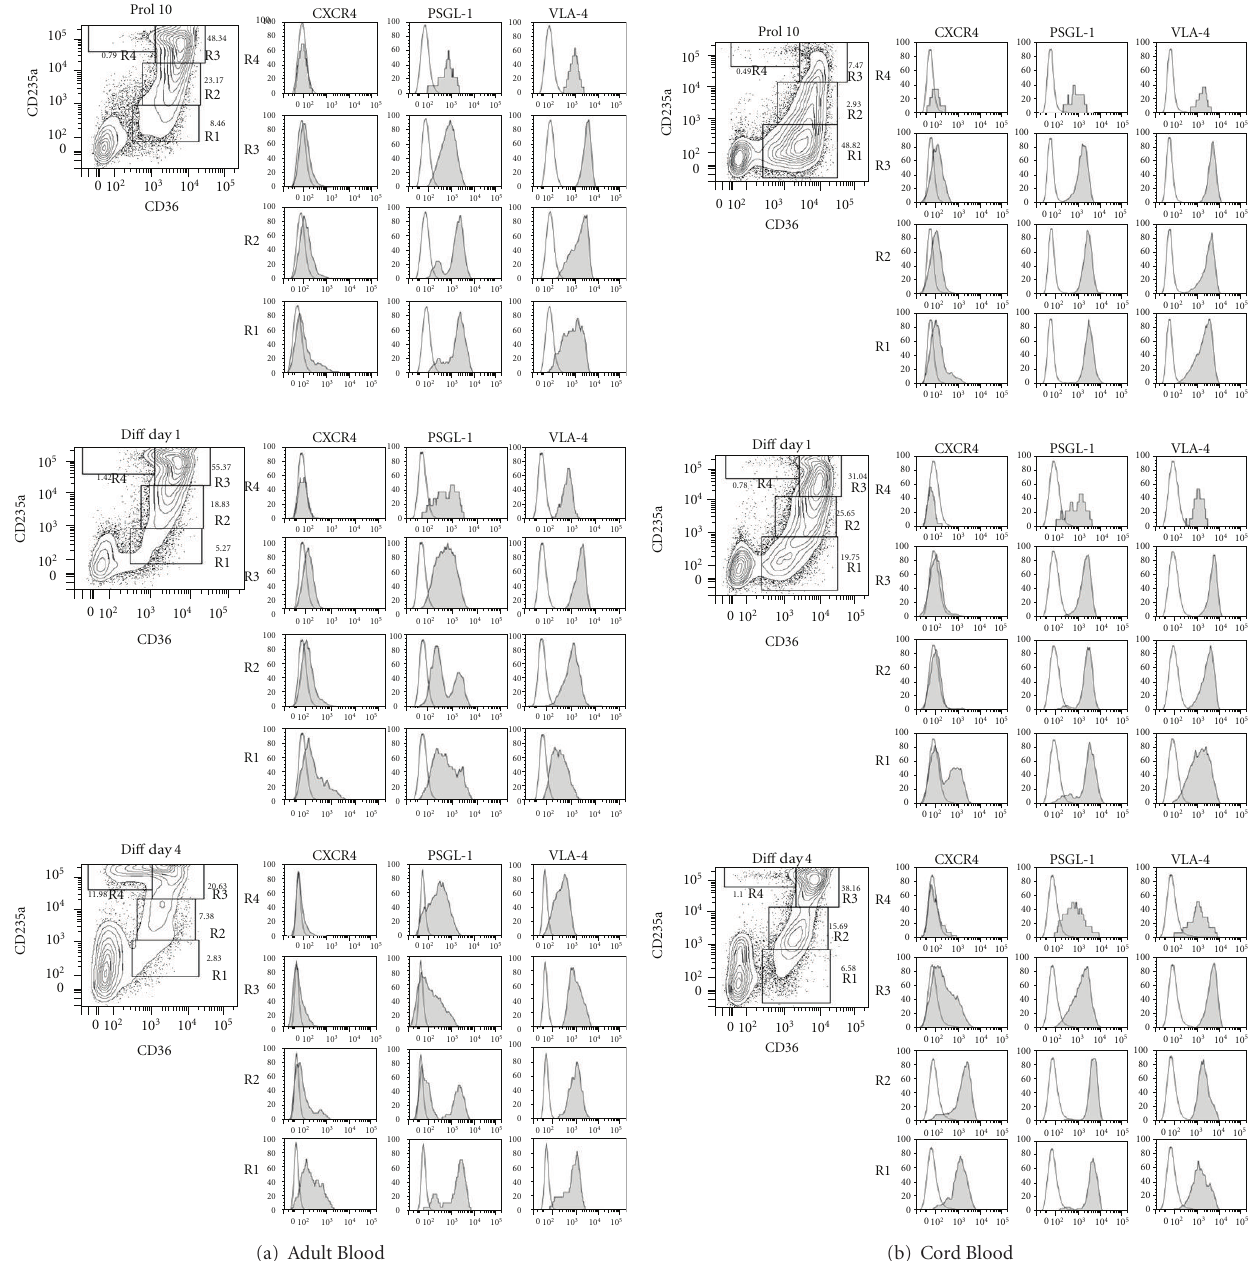
Figure 2: Adhesion receptor profiling during in vitro maturation of EBs expanded from AB (a) and CB (b). Three color flow cytometry analysis for CD36 and CD235a in combination with either CXCR4 (CD184), PSGL-1 (CD162), or VLA-4 (CD49d) of EBs obtained at day 10 of HEMA culture from AB and CB MNC (Prol 10) and at day 1 (Di ff Day 1) and 4 (Di ff Day 4) of maturation with EPO alone, as indicated. EBs were divided into 4 maturation classes defined by the levels of CD36 and CD235a expression identified by the gates R1 to R4 and corresponding to Class 1 to 4 (see Supplemental Figure 3 for further